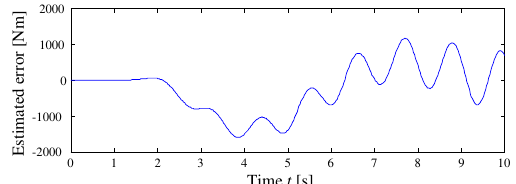
Figure 11. Estimated error of H ∞ observer at parameter error − 20%.